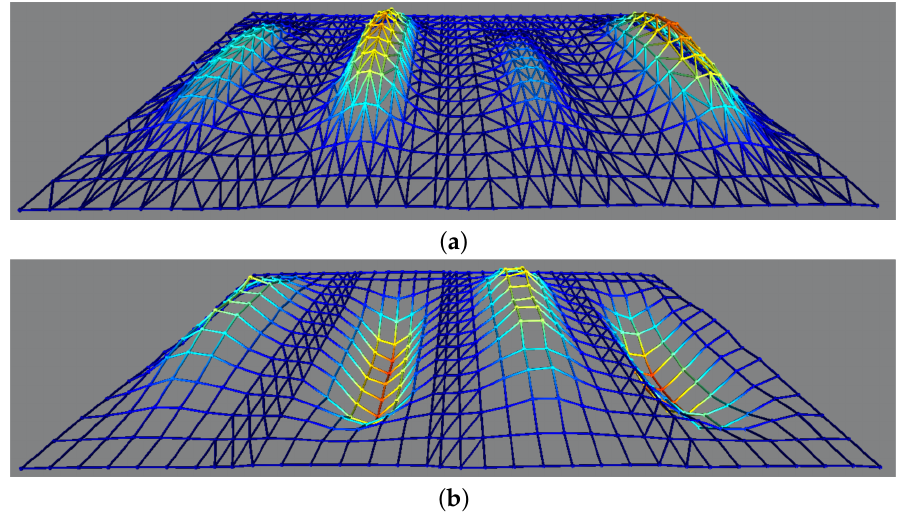
Figure 9. Surface vibrations of the whole array measured with the help of a 3D PSV vibrometer mounted on a robotic arm for in-phase ( a ) and 90 ◦ out-of-phase ( b )